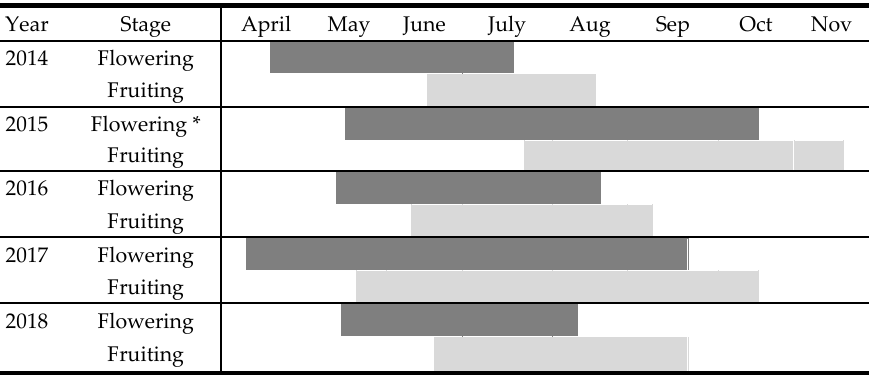
Figure 2. Flowering and fruiting period of M. browiczii during five consecutive years (2014–2018). * Subpopulation Mb3 exhibited extended flowering period during 2015 (from 4 May 2015 to 31 January 2016). 2.4. Chlorophyll Fluorescence Measurements Chlorophyll fluorescence measurements were performed to assess the state and the level of stress on the photosynthetic apparatus of the subpopulations (Figure 3). Maxi- mum quantum yield of primary PSII photochemistry (φP 0 ), which is the most conserva- tive index, showed little variation among different subpopulations. The other indices (quantum yield for reduction in end electron acceptors at the PSI acceptor side (φR 0 ), po- tential for energy conservation from exciton to the reduction in PSI (Photosystem I) end acceptors (PI total ), absorbed photon flux per active reaction centre (ABS/RC), dissipated energy flux per active reaction centre (DI 0 /RC) and measure of the relative amplitude of K band (V K /V J )) showed significant variation among subpopulations. The results indi- cated a major influence of the microenvironment on the performance of the photosyn- thetic apparatus. A common trend among indices was recorded, with low values of φR 0 and PI total accompanied by high values of ABS/RC, DI 0 /RC and V K /V J . More specifically, there was a hindered capacity of electron flow between and around the photosystems (low values of φR 0 and PI total ), accompanied by inactivation of reaction centers (high values of ABS/RC), increased heat dissipation (high values of DI 0 /RC) and a looser connection of OEC (Oxygen Evolving Complex) with PSII (high values of V K /V J ). When comparing the local endemic M. browiczii to the widespread M. juliana at the same locations, only marginal differences were obtained and a similar profile of energy flow in the photosynthetic apparatus was found (Figure 3). Minor or no significant differ- ences were also recorded between plants growing on different substrates (Figure S1) and between matures and juveniles (Figure S2), while altitude (Figure S3) showed no correla- tion with any of the fluorescence parameters. Finally, no significant correlation was found between chlorophyll fluorescence parameters and the number of reproductive individuals (Figure S4) or the relative reproductive success (Figure S5).